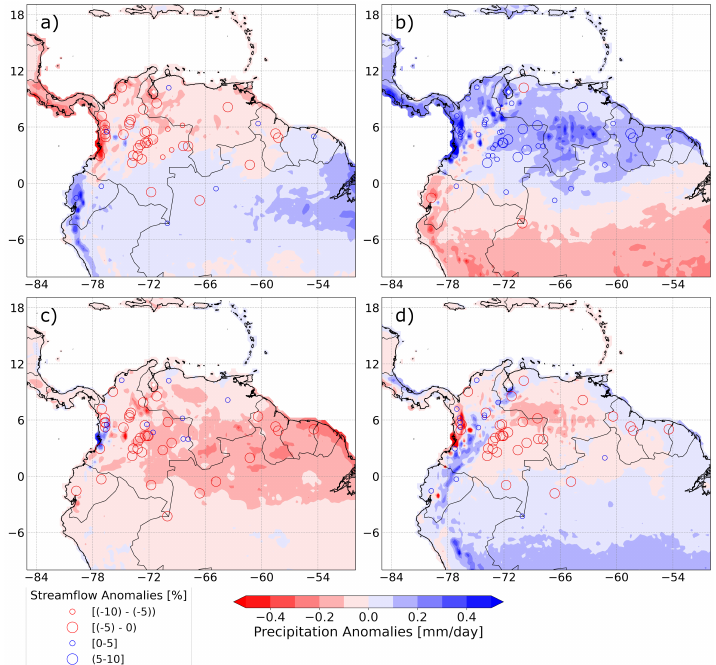
Figure 7. Seasonal synoptic anomalies of precipitation (colors) and streamflows (circles), over the region of study for the period 1981–2019. ( a ) DJF; ( b ) MAM; ( c ) JJA; ( d )